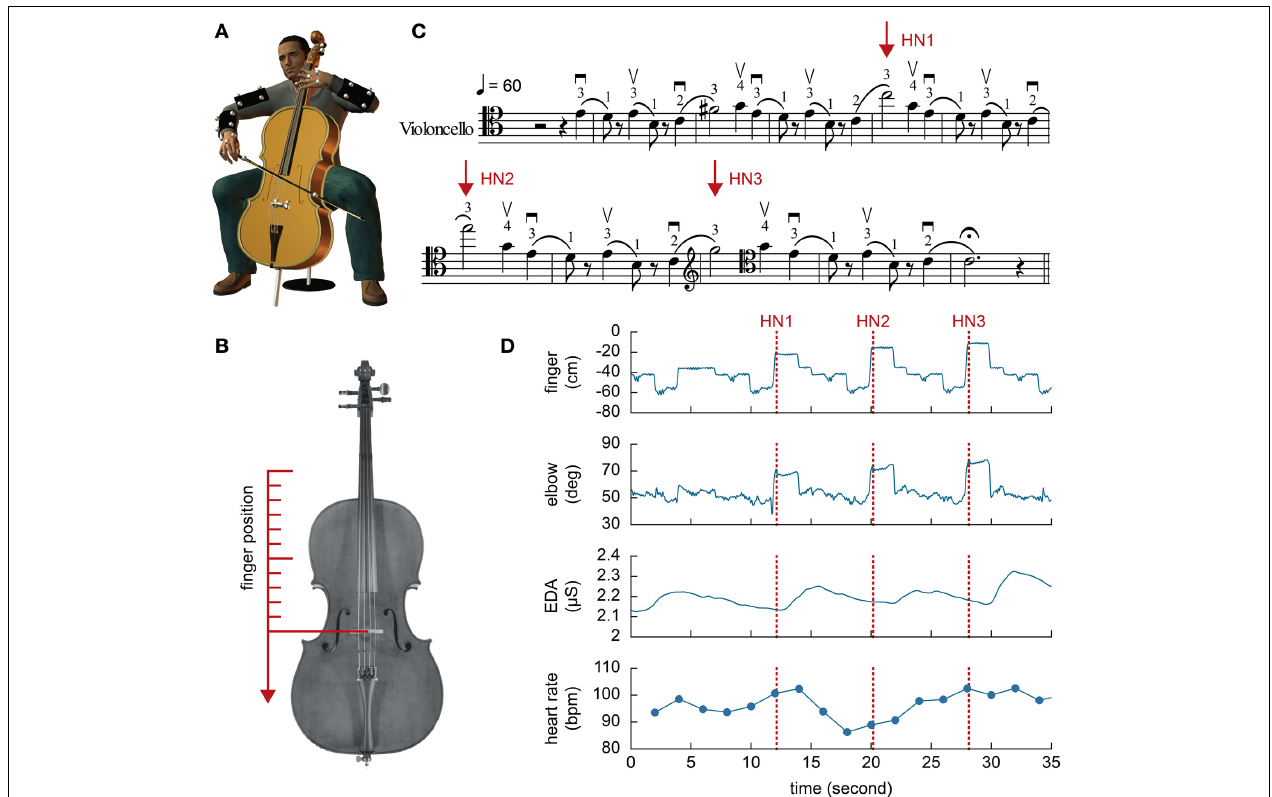
FIGURE 1 | (A) Illustration of the experimental setup. A total of 29 small markers were attached to the upper body of the participants and the instrument. (B) The left hand ring finger position was transformed to align with the longitudinal axis of the instrument and the bridge on the cello was used as the center of the Cartesian coordinate. (C) Music score designed for the purpose of the present study. The three high